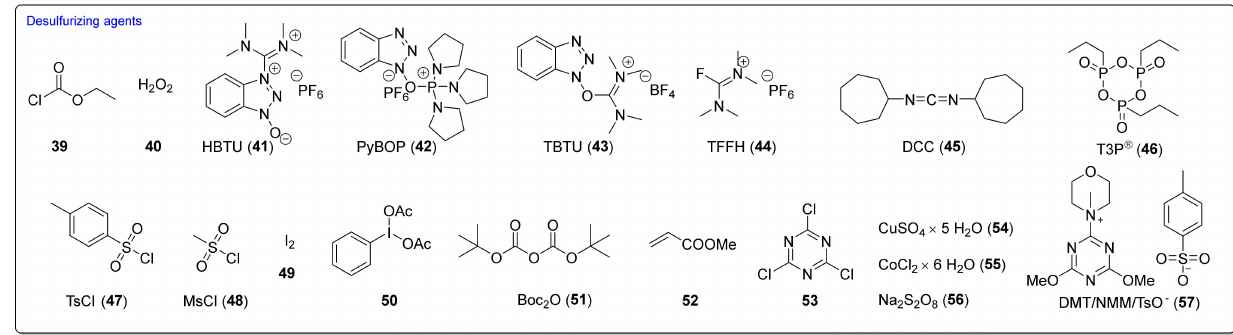
Figure 12. Selected desulfurizing